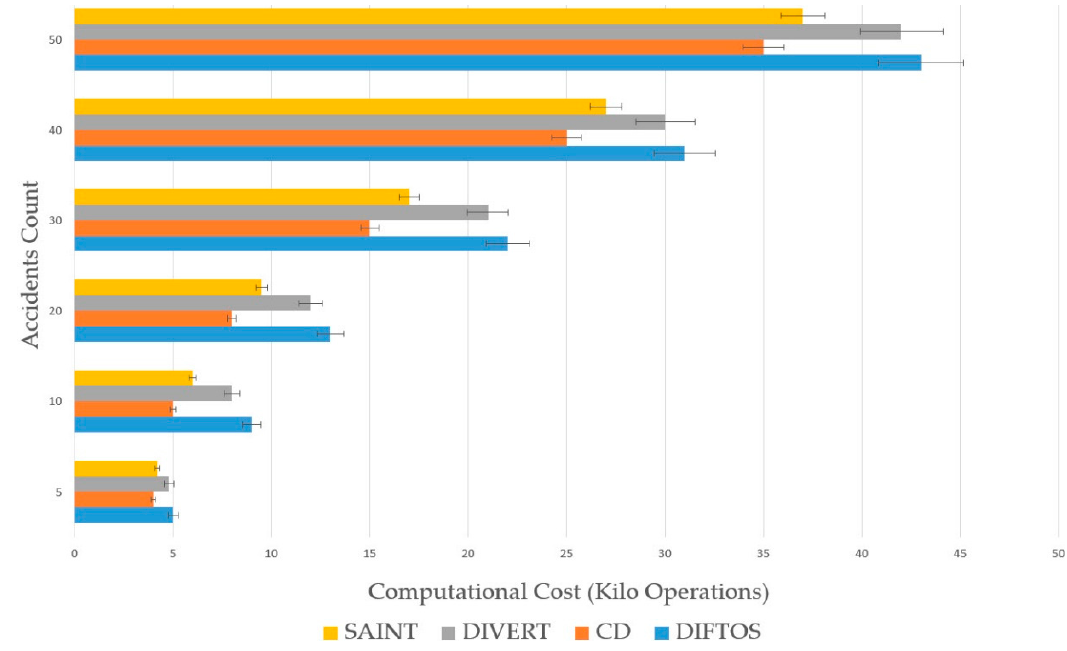
Figure 9. Accident count vs. computational cost.